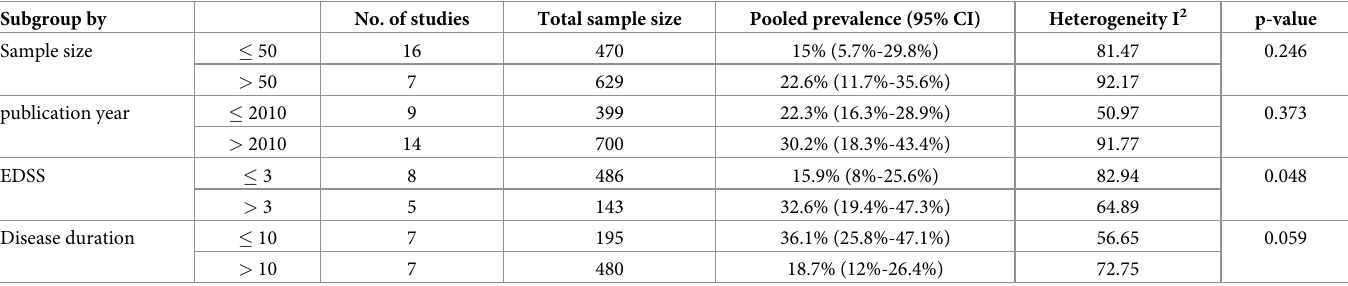
Table 2. Subgroup analysis of pooled prevalence of